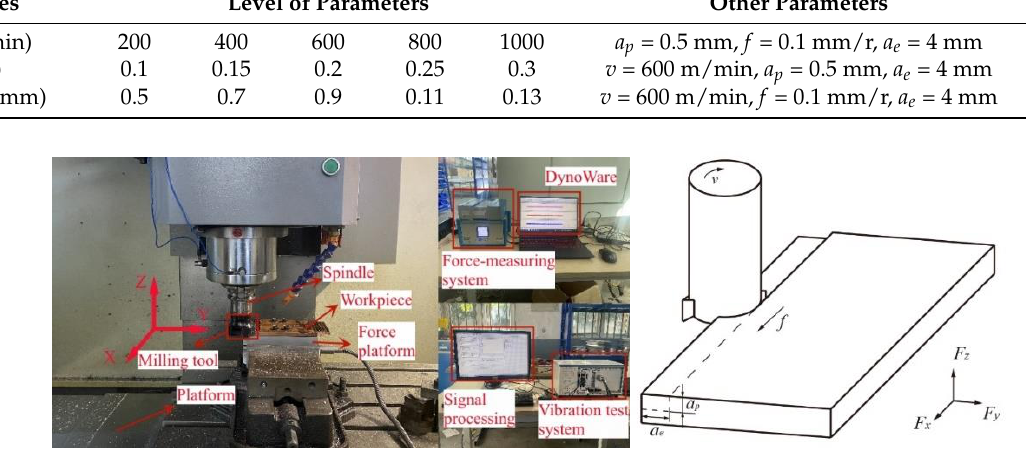
Table 2. Cutting force and tool displacement acceleration test parameters for the T2 pure copper milling. Independent Variables Level of Parameters Other Parameters